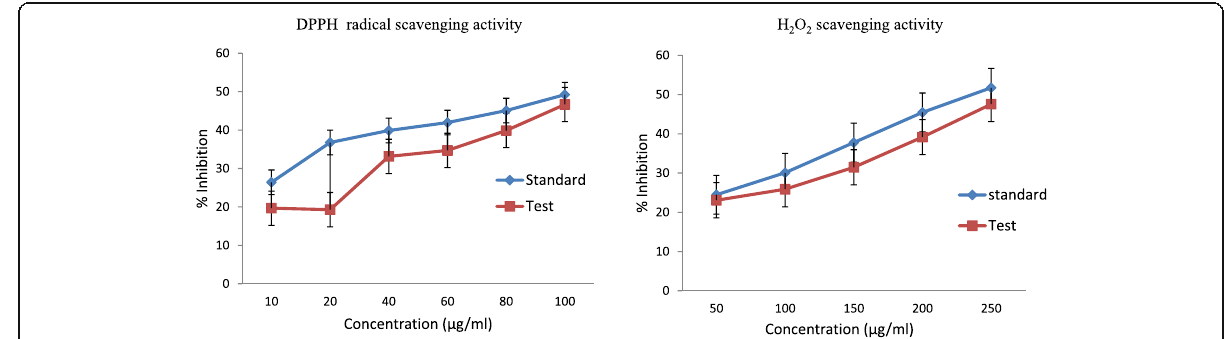
Fig. 4 MELCL antioxidant activity analysis by DPPH and Hydrogen peroxide scavenging activity model. MELCL : Methanolic extract of Luffa cylindrica (L.) leaves. DPPH: 2,2-Diphenyl